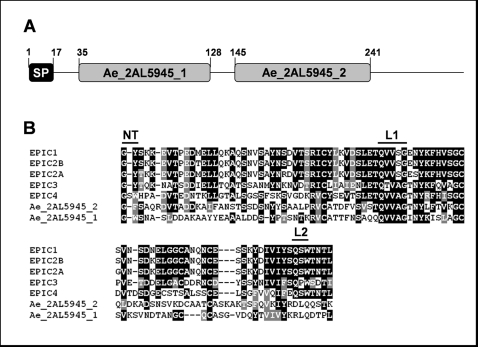
A cystatin-like protease inhibitor in A. euteiches.
A, domain organisation of the deduced protein sequence of Ae_2AL5945. A putative signal peptide (SP) and two domains similar to cystatin domain are shown. B, alignment of cystatin domains from P. infestans cystatins (EPIC1, EPIC2A, EPIC2B , EPIC3 and EPIC4) and from Ae_2AL5945. The active sites of cystatins, including the N-terminal trunk (NT), first binding loop (L1), and second binding loop (L2), are shown.